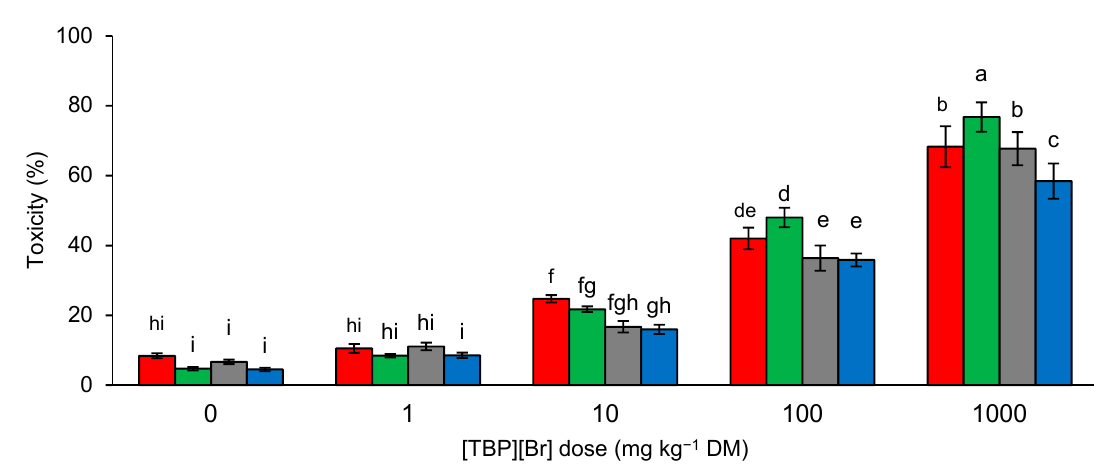
Figure 5. Ecotoxicity of tetrabutylphosphonium bromide [TBP][Br]-exposed soil to A. fischeri in pot experiment with spring barley; data are presented as mean ± SD; values denoted by the same letters do not differ significantly at the level of p = 0.05 (Tukey HSD test).